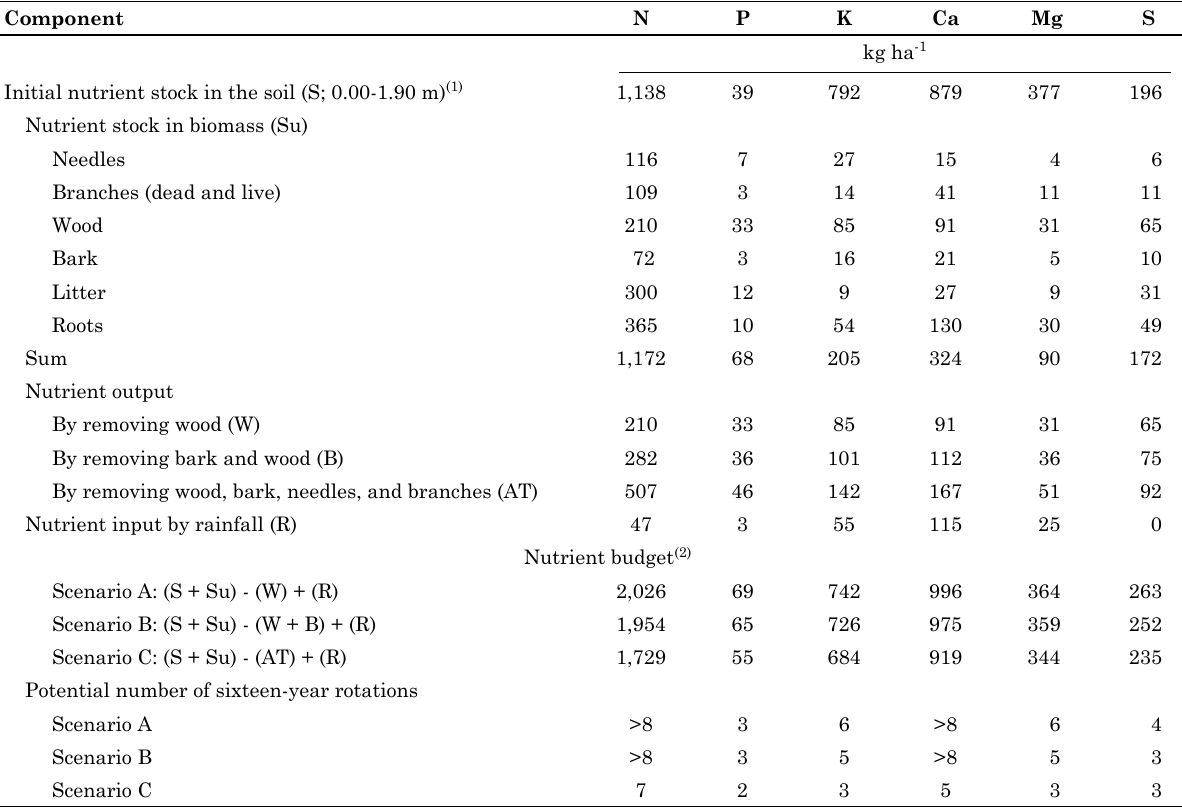
table 5. an estimated nutrient budget and potential number of 16-year rotations under three management scenarios for plantings of Pinus taeda established in a humic endo-lithic dystrudept (mean